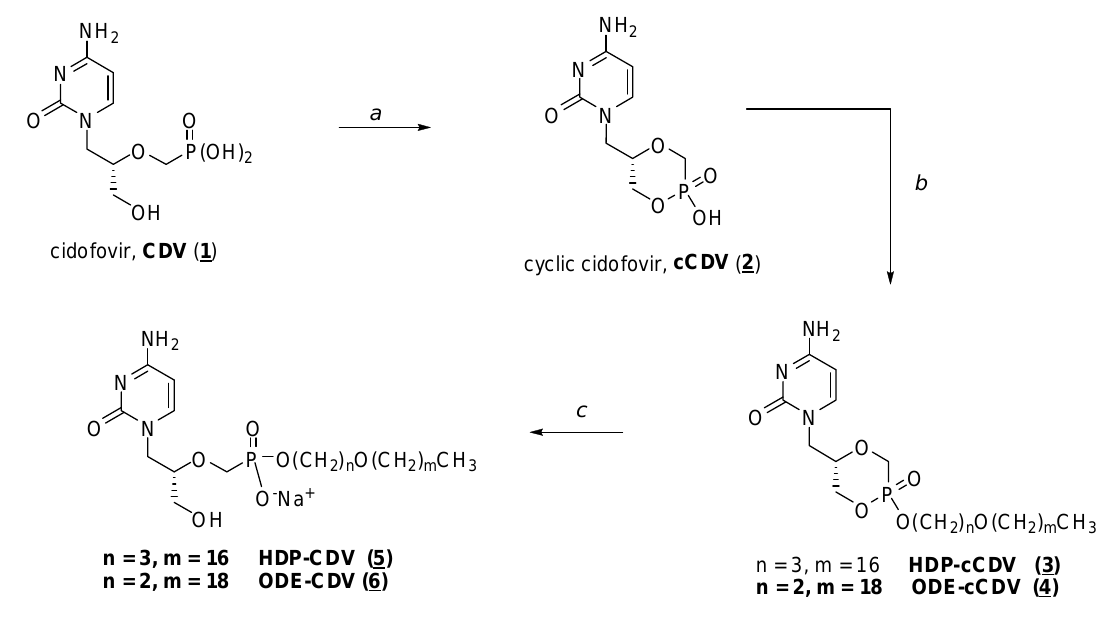
Figure 2. Synthesis of HDP-CDV and ODE-CDV.